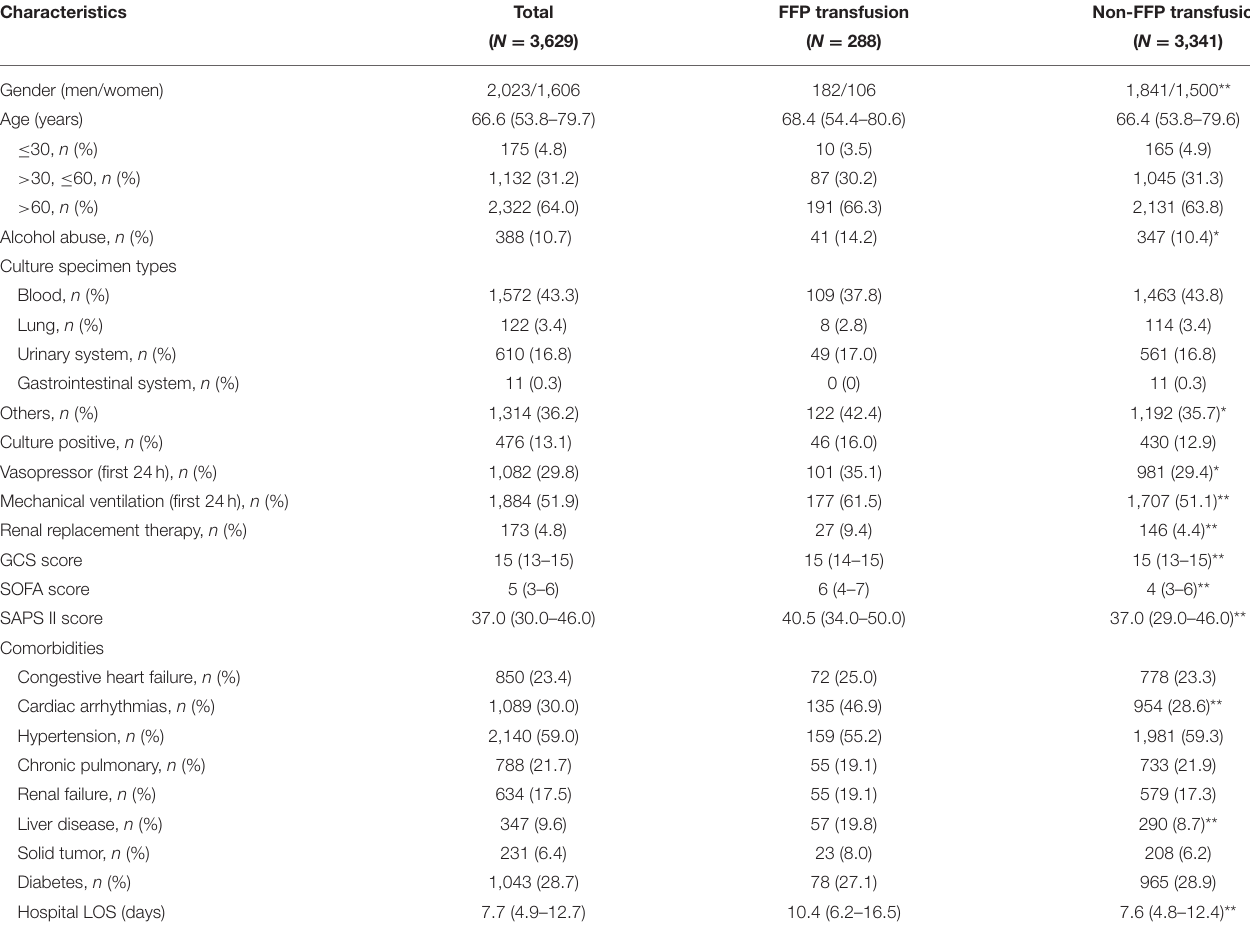
TABLE 1 | The baseline characteristics of study cohort.